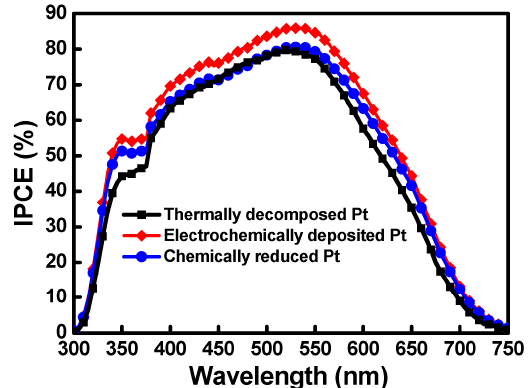
Figure 7. IPCE spectra of DSSCs based on various Pt CEs.